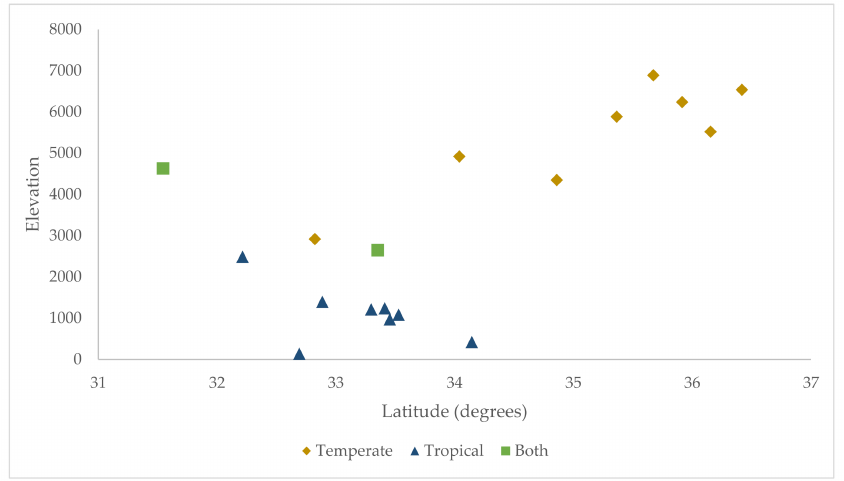
Figure 3. Distribution of R. sanguineus s.l. lineages across latitude and elevation of collection sites.